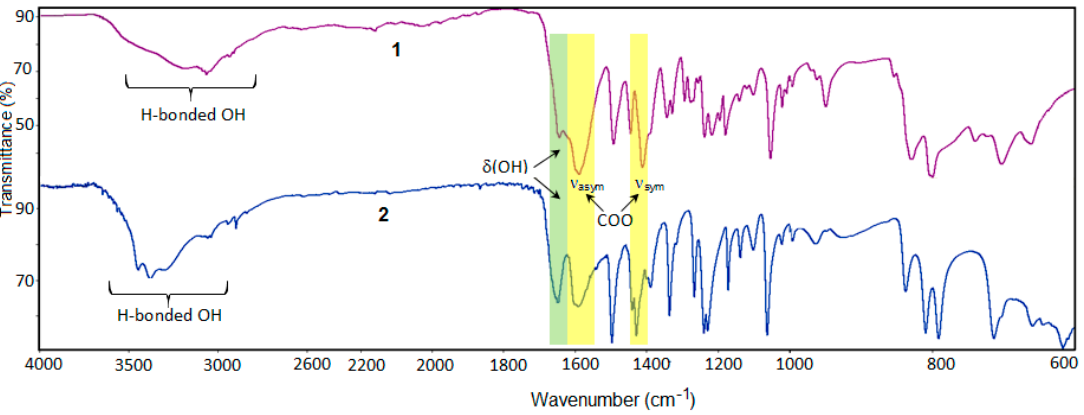
Figure 4. Infrared spectra of 1 and 2 .